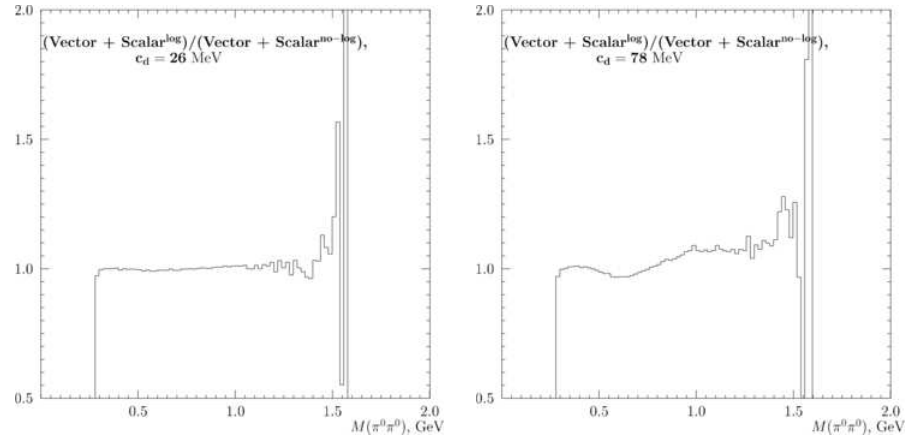
Figure 7 . Plots for the ratios of the √ s 3 = M π 0 π 0 spectral functions for τ of the full result and the spectral function without the real part of the logs in the σ propagator for c d = 26 MeV; b) ratio of the full result and the spectral function without the real part of the logs in the σ propagator for c d = 78 MeV. In order to better pin down the impact of the scalar propagator structure we only consider the vector+scalar contribution, dropping the